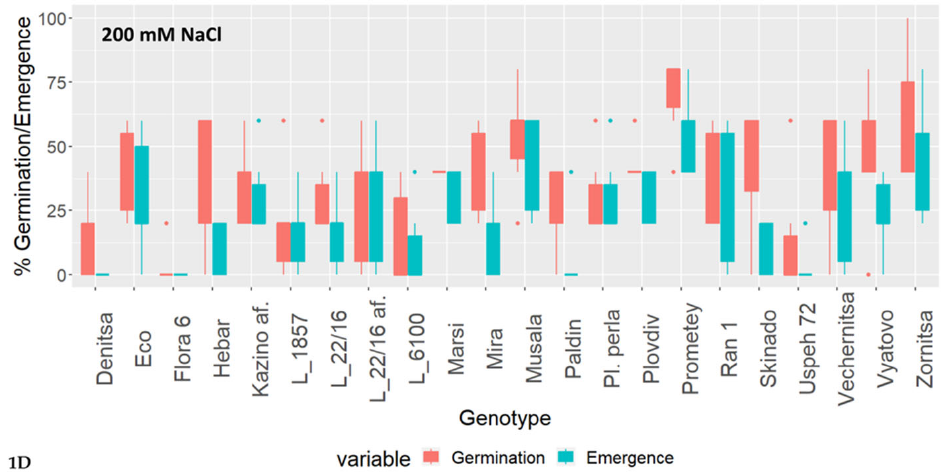
Figure 1. In vitro seed germination and seedling emergence rates boxplot for 22 garden pea genotypes under four levels of salinity: ( A ) 0 mM; ( B ) 50 mM NaCl; ( C ) 100 mM NaCl; ( D ) 200 mM NaCl.